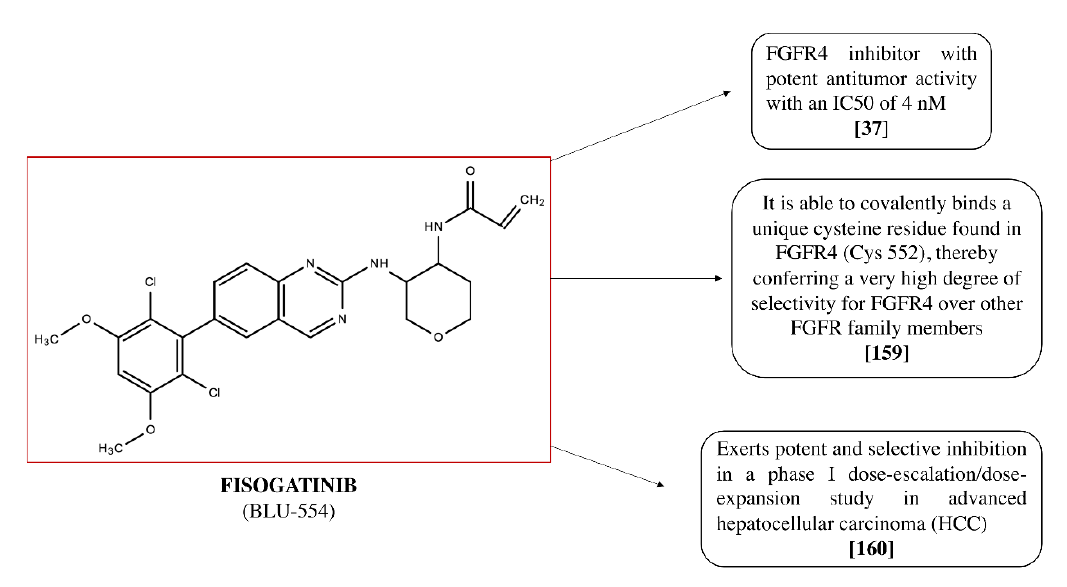
Figure 3. Chemical structure of Fisogatinib (BLU-554) and its properties.